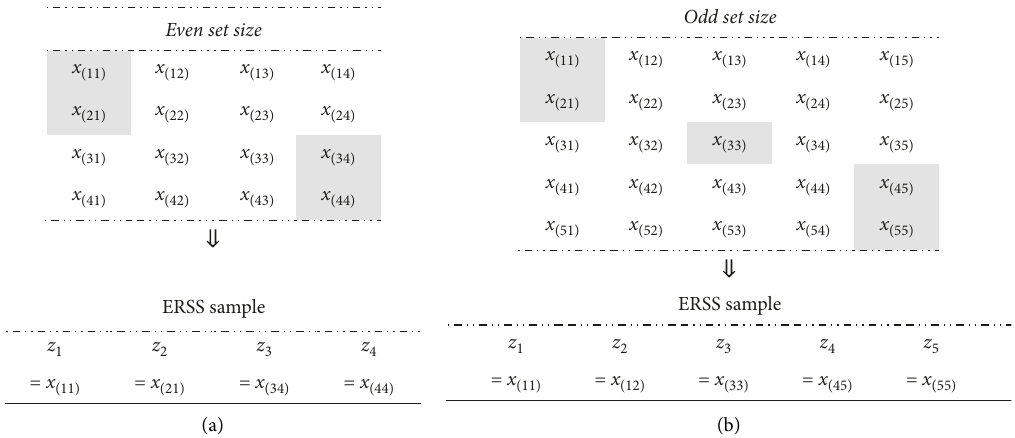
Figure 3: Display of m 2 observations in one cycle and the selected ERSS sample of size: (a) m � 4 and (b) m �